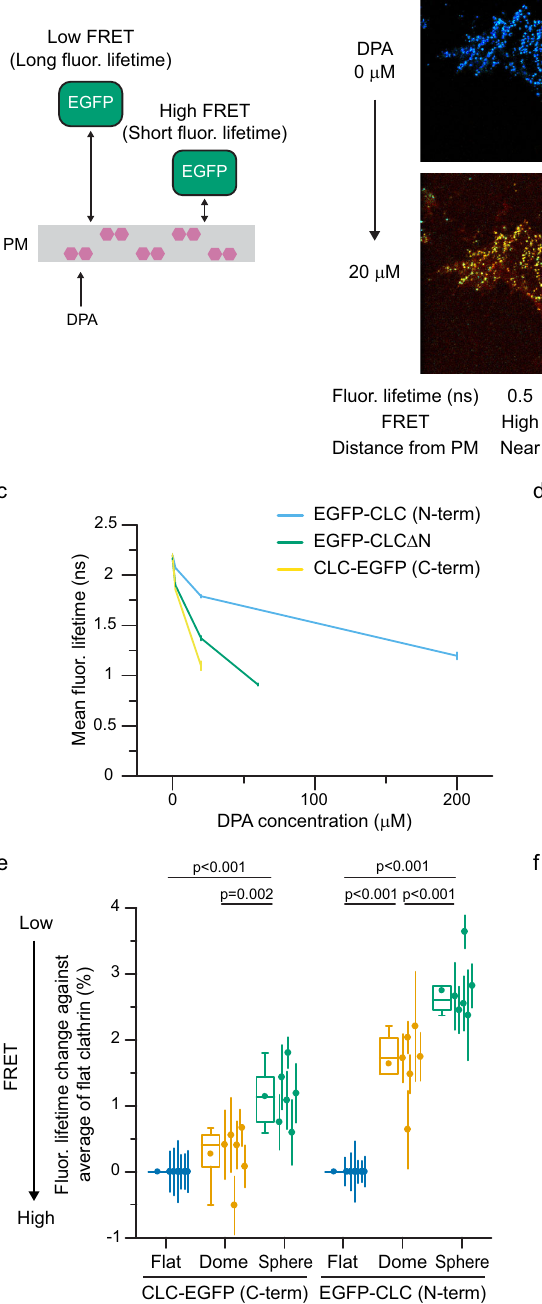
of fl uorescence lifetime changes similar. Mean fl uorescence lifetimes from single CCSs were analyzed by categorizing them according to lattice structures and compared to average values of fl at structures. n =6 cells from 4 experiments for each condition. Each dot is from one cell experiment and errors are SE. One-way ANOVA, then Tukey ’ s test. For box plots, box is interquartile range, center line is median, center circle is mean, whiskers are minimum and maximum data points withacoef fi cientvalueof1.5. f AproposedstructuralmodelofCLCconformational changes predicted from both FRET-CLEM with EGFP-ShadowY and EGFP-DPA. The N-terminus of CLC moves away from both the CLC C-terminus (triskelion vertex) and the plane of the plasma membrane as clathrin lattices curve. The structural model is based on PDB 3LVG. Source data are provided as a Source Data fi